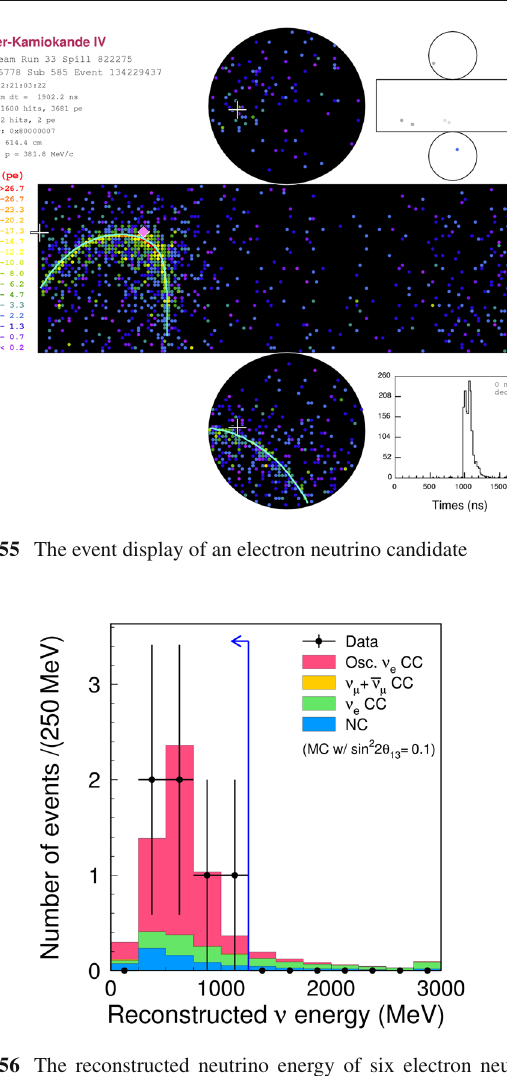
Fig. 56 The reconstructed neutrino energy of six electron neutrino events